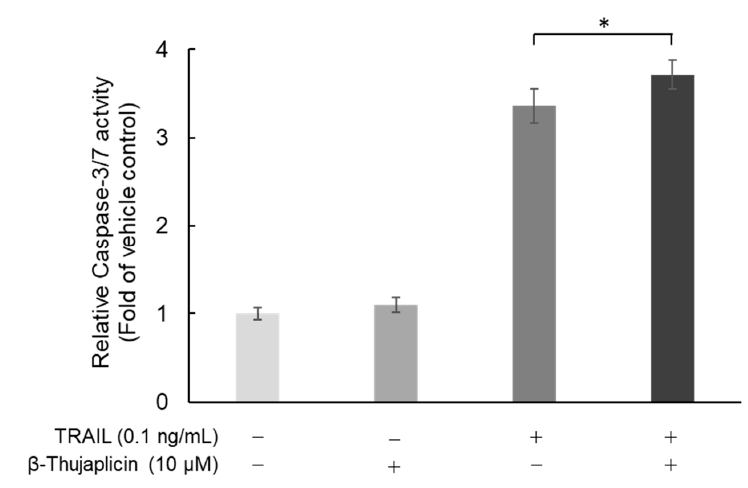
Figure 5. Enhancement of caspase-3/7 activity in TRAIL-treated NCI-H460 cells through combination treatment with β -thujaplicin. NCI-H460 cells were cotreated with 0.1 ng/mL TRAIL and 10 µM β -thujaplicin for 24 h. Caspase-3/7 activity was then measured by a Caspase-Glo ® 3/7 Assay System. Data are the averages of three independent experiments and error bars show standard deviations. * p < 0.05.